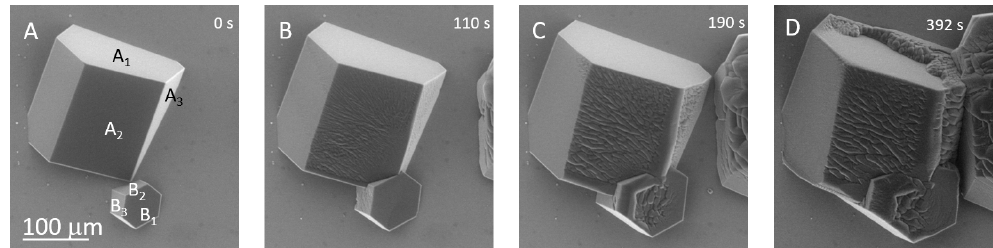
Figure 3. Isolated crystals merging during growth. As soon as the crystals touch, the planes in contact show polycrystalline topography with a large density of grooves. ESEM imaging conditions: (a, b, c) P = 130 . 2Pa, T = − 17 . 9 ◦ C, P sat = 126 . 2Pa, h = 1 . 03; (d) P = 126 . 8Pa, T = − 18 . 3 ◦ C, P sat = 121 . 5Pa, h = 1 . 04. The images show the same area of the sample.